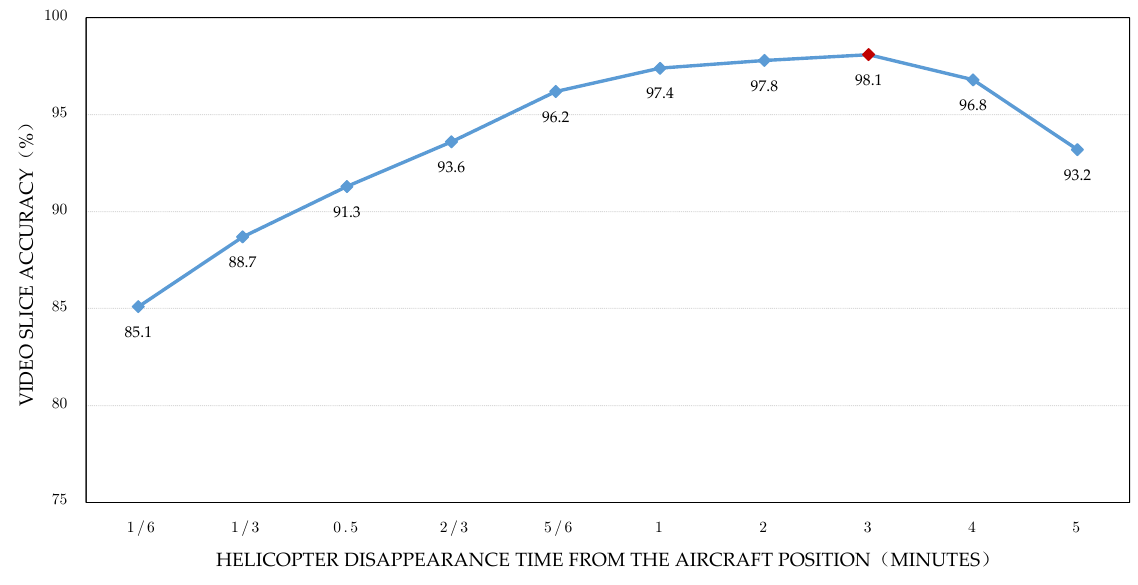
Figure 9. Comparison of the effect of vanishing time length on cutaway video.